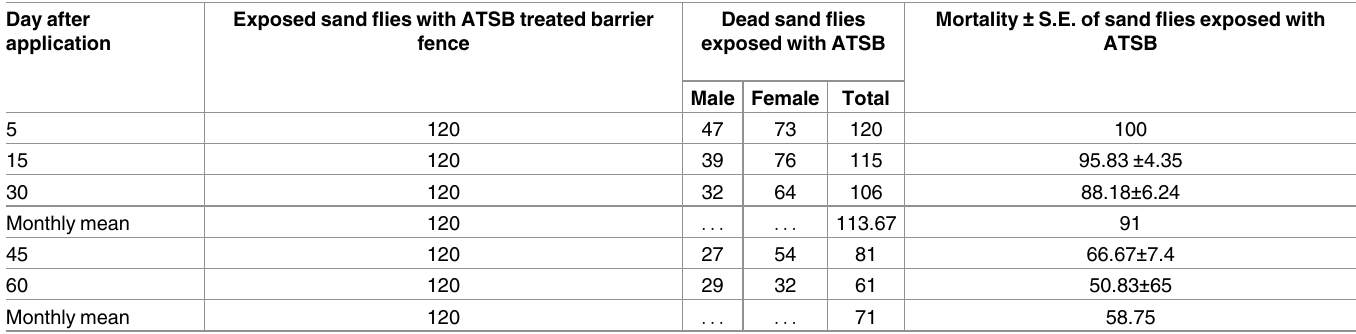
on barrier fences is an effective means against sand flies [8]. In addition, the comparison of the incidence of ZCL pre and post-study phases showed that the ATSB is an effective method in significantly decreasing the incidence of ZCL in treatment villages. With the decline in the abundance of P . papatasi in the study area, it is safe to expect the reduction of the number of infectious bites and the incidence of the disease. Based on the bioassay test, the residual rate of ATBS-treated barrier fences effective substance in Qom Province climate was estimated at 45 days at most. So, every 45 days, barrier fences were impregnated with ATSB. To the best of our knowledge, this method is cost-effective and efficacious for vector control.